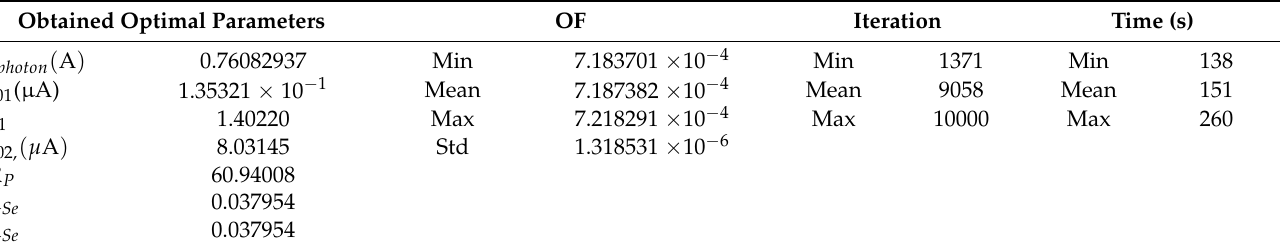
Table 5. Obtained statistical results for DDM solar cell.